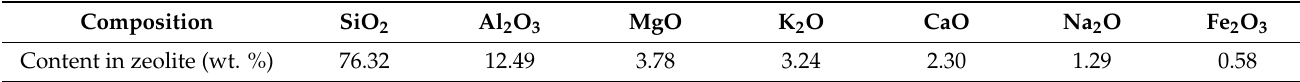
Table 2. The main components and content of